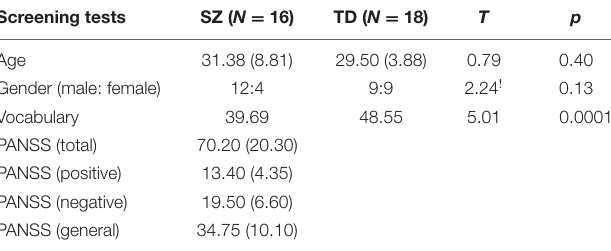
TABLE 1 | Demographic characteristics, by